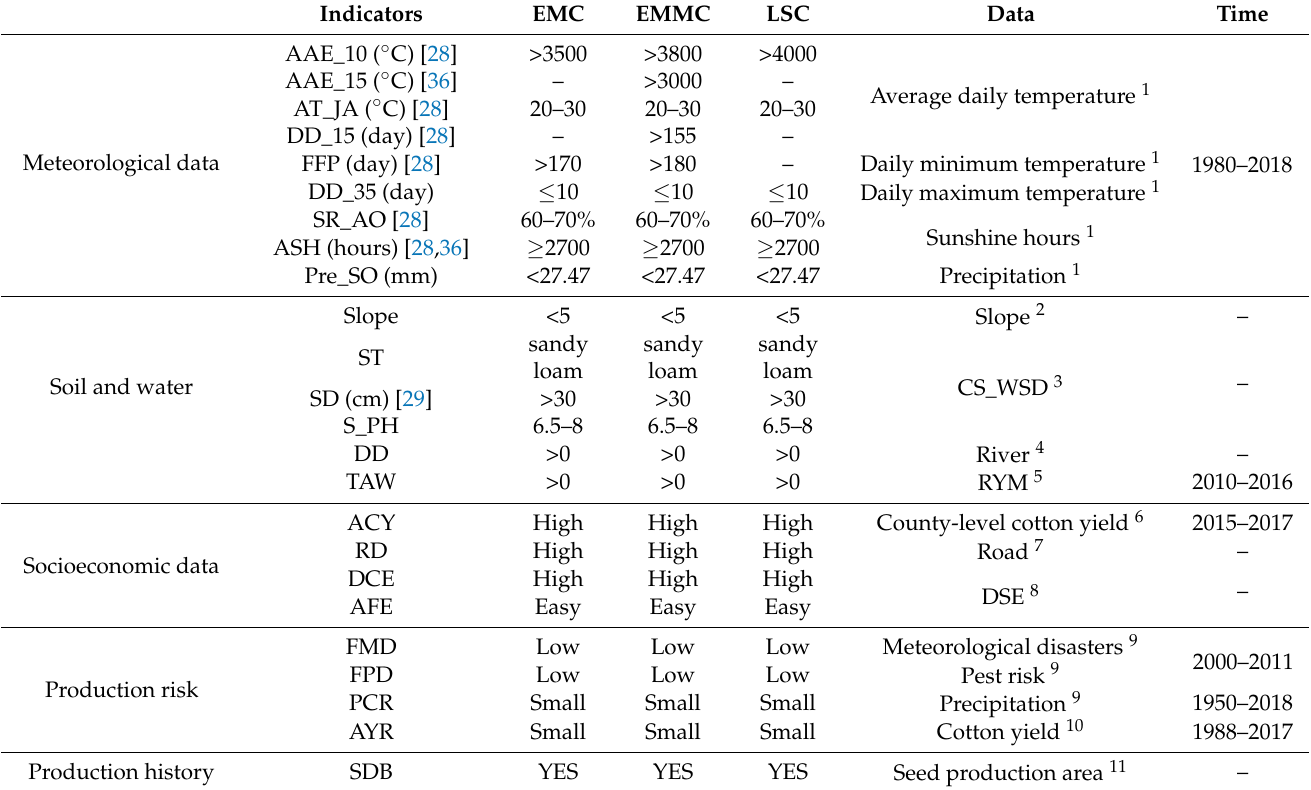
Table 1. Indicators for cotton seed production of three cotton varieties based on a literature survey and expert